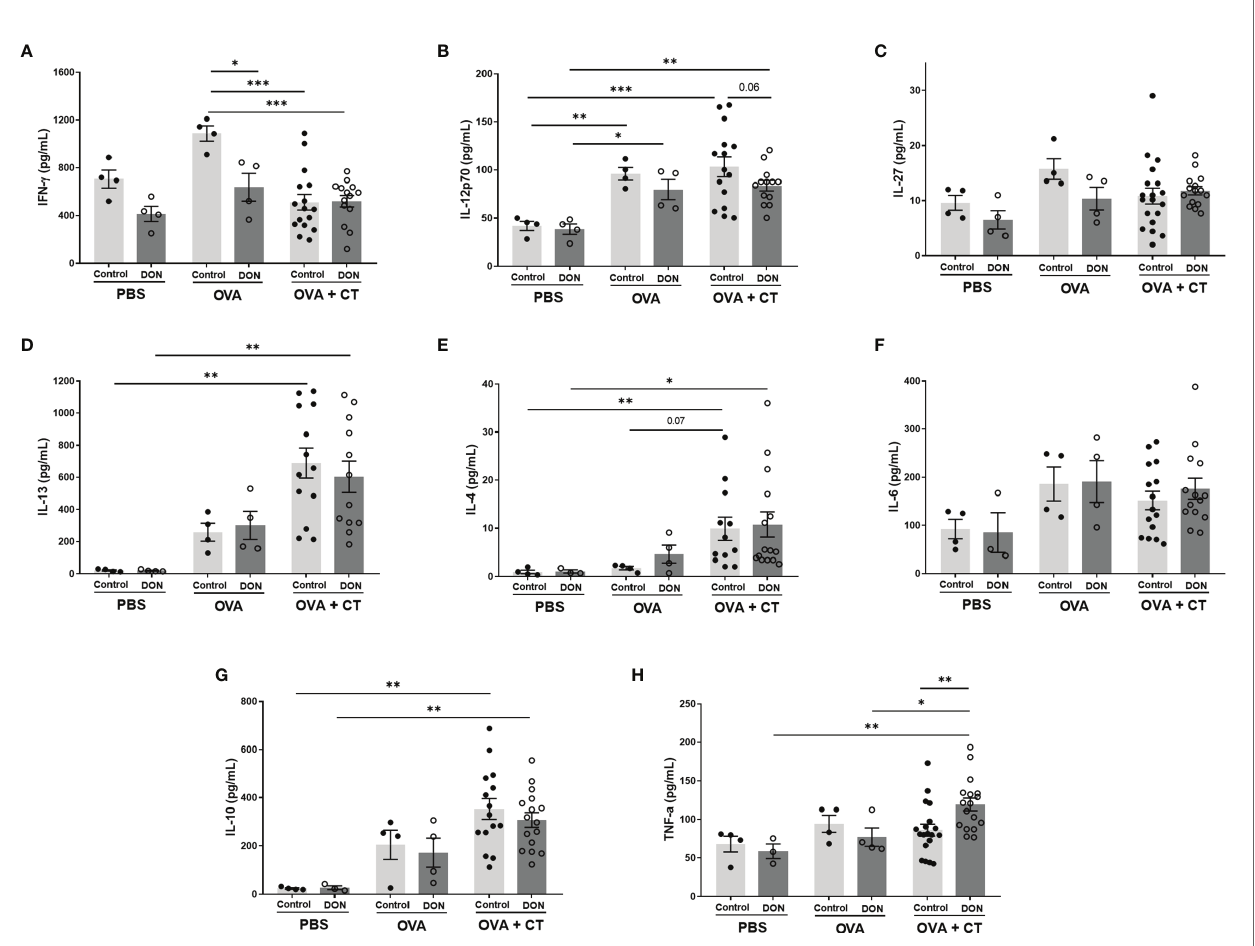
FIGURE 6 | Maternal deoxynivalenol (DON) exposure modulated the cytokine production of ovalbumin (OVA)-stimulated splenocytes of female offspring ex vivo . Pregnant mice fed either a control or DON-contaminated diet (12.5 mg/kg) during pregnancy and lactation period. Female offspring received oral sensitizations with either phosphate-buffered saline (PBS), OVA, or OVA with cholera toxin (CT) after weaning. A week after the last sensitization, female offspring were sacri fi ced and collected splenocytes were re-stimulated ex vivo with OVA. (A – H) Interfe ́ ron (IFN)- g , interleukine (IL)-12p70, IL-27, IL-13, IL-4, IL-6, IL-10 and tumor necrosis factor (TNF)- a concentrations. Data are presented as mean ± SEM. *p < 0.05, **p < 0.01 and ***p < 0.001 indicate statistical